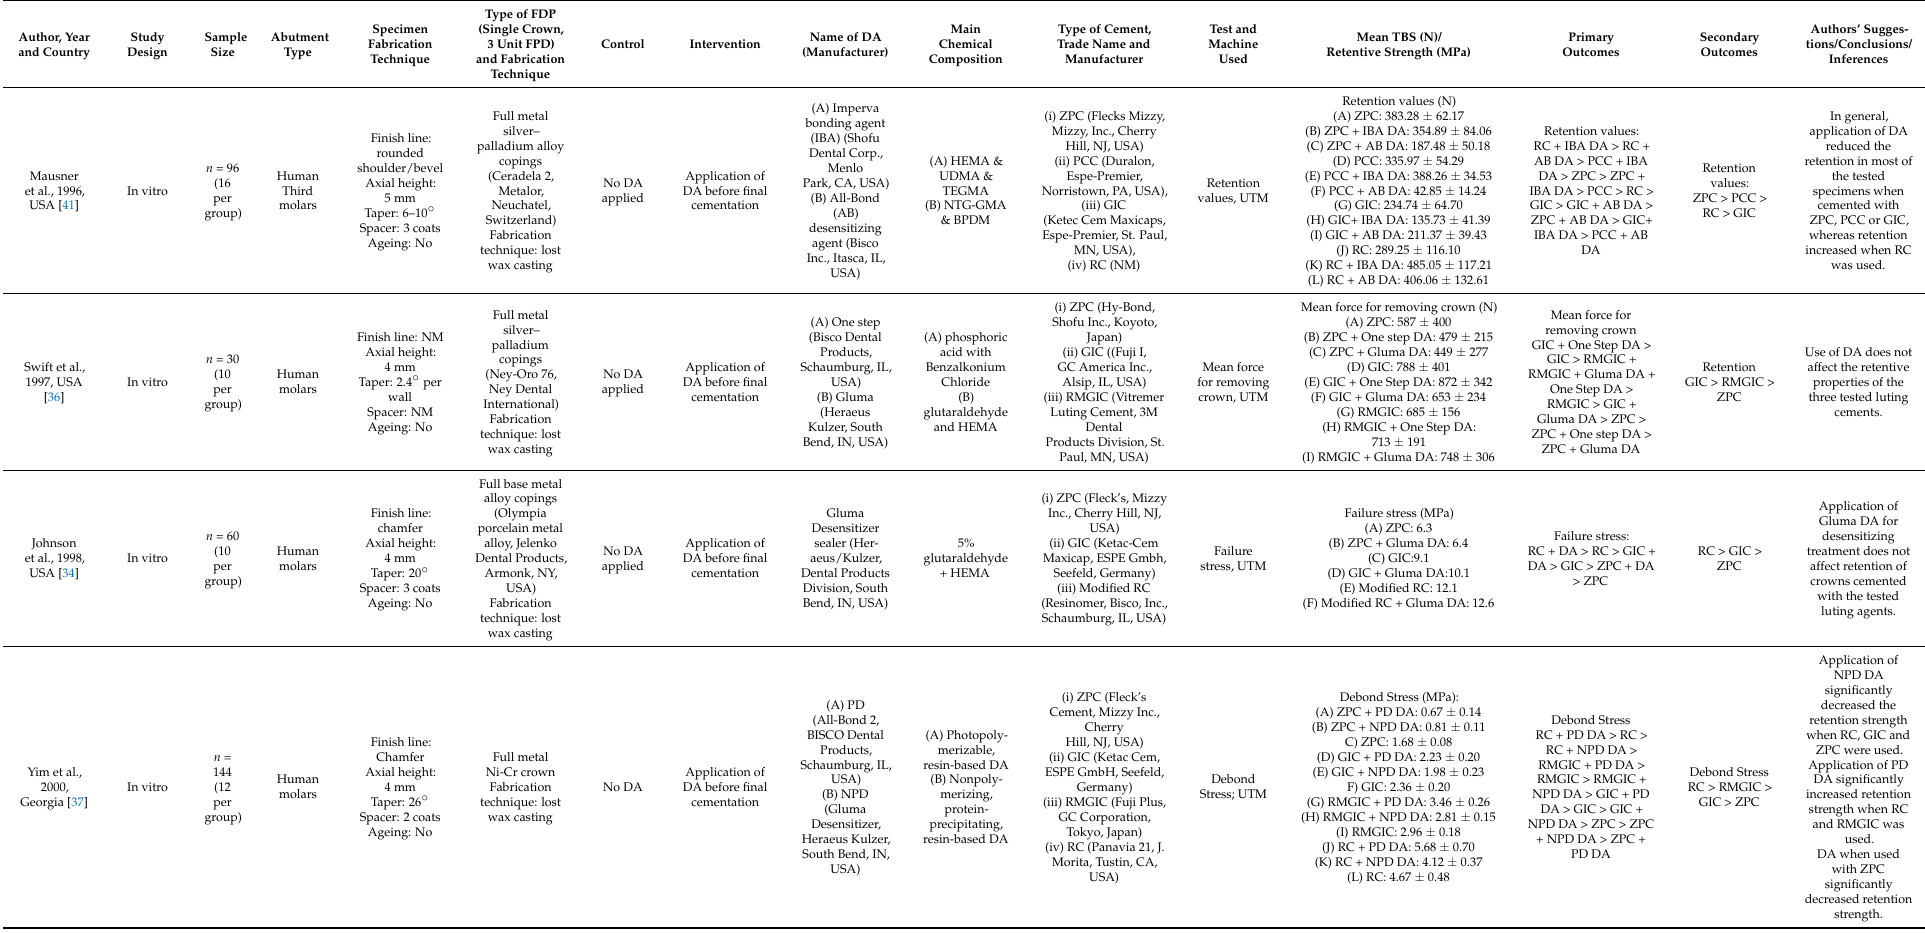
Table 1. General characteristics and specific results of the included